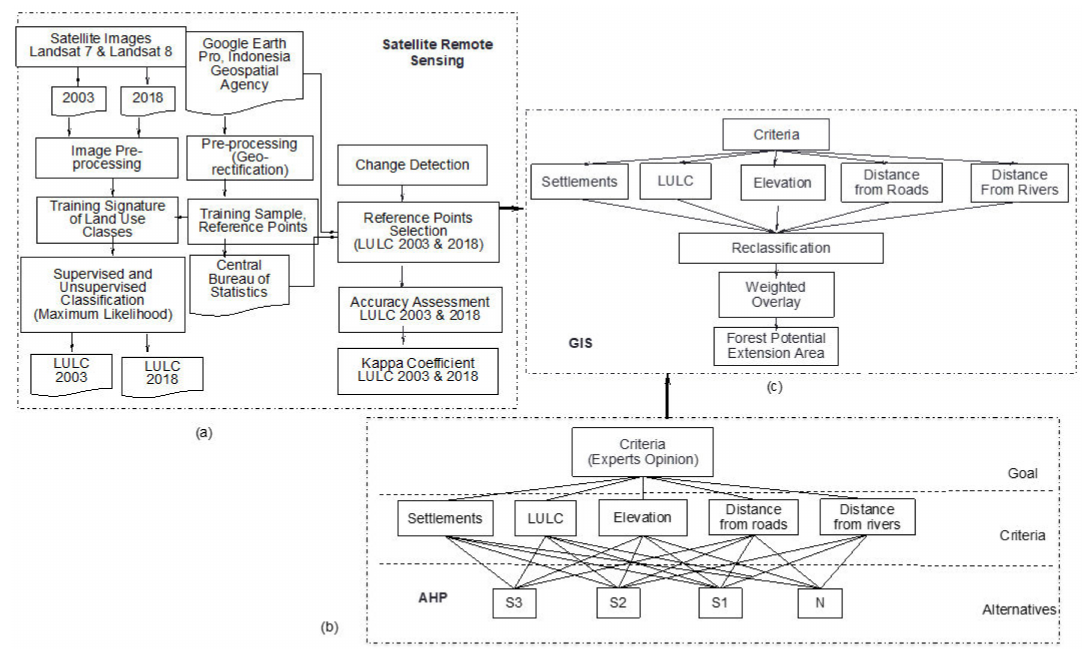
Figure 2. Research framework for land suitability analysis to propose the extension of potential forest area. ( a ) Land use and land cover for change detection analysis from Landsat 7 and Landsat 8 OLI datasets; ( b ) Analytical Hierarchy Process (AHP) to integrate the expert opinion’s weight in